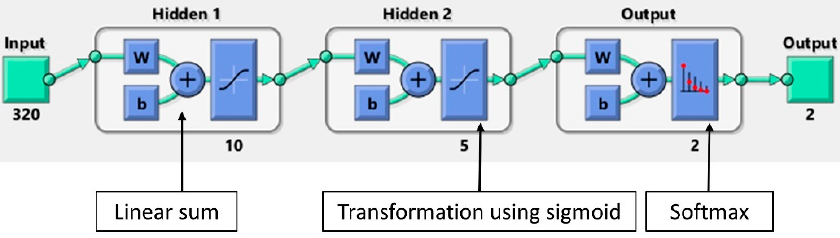
Figure 6. Pattern recognition neural network used in this study for wheat lodging detection, consisting of two hidden layers (10 and 5 neurons) with input (320 features), and output (lodging and non-lodging). w and b stand for weight matrix and bias, respectively.